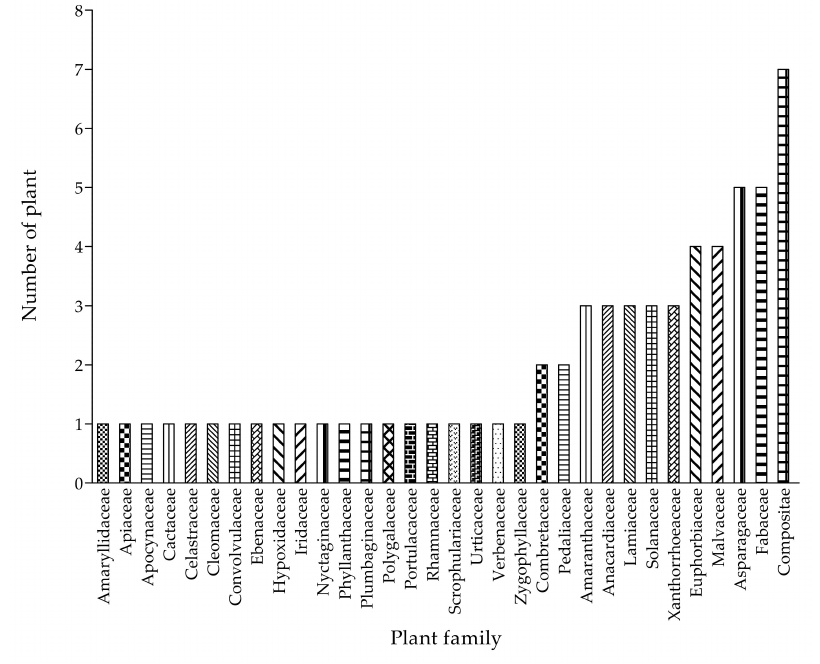
Figure 1. Frequency of the 32 plant families used in the treatment of cattle diseases in the Ramotshere Moiloa local municipality, North West Province, South